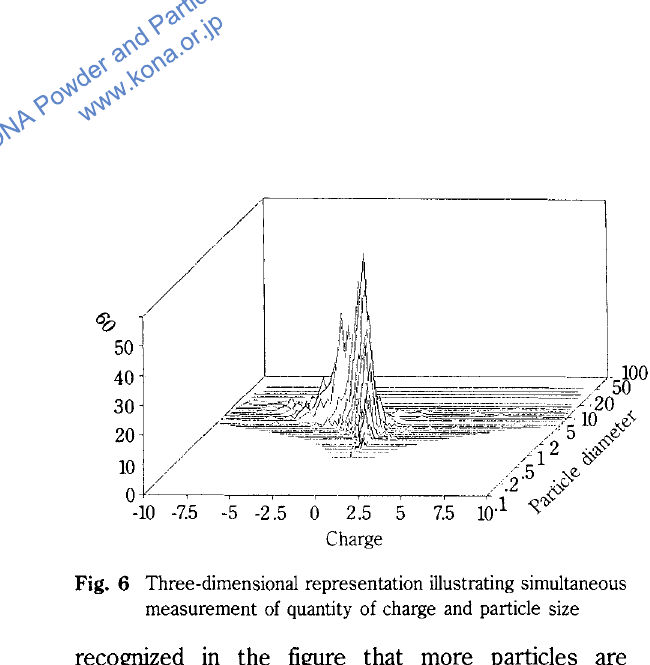
Fig. 6 Three-dimensional representation illustrating simultaneous measurement of quantity of charge and particle size